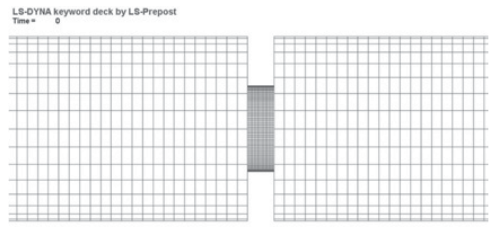
Fig. 4. Simulation model for split Hopkinson pressure bar